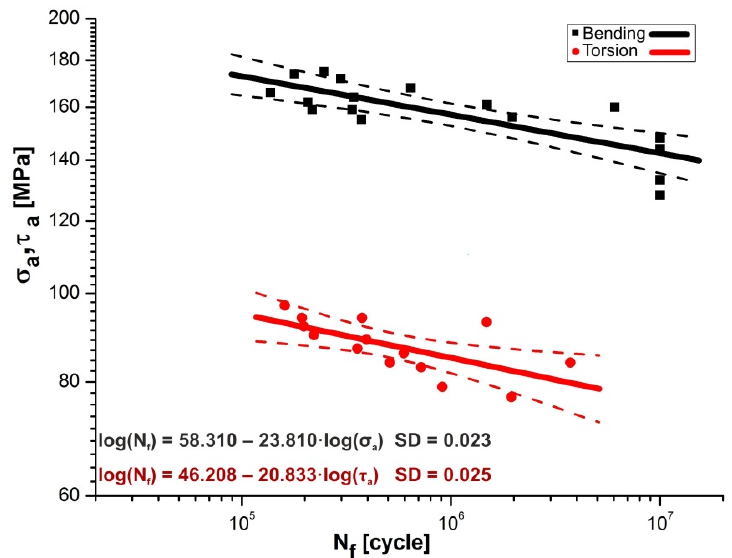
Figure 5. Basquin’s characteristics of regression lines with confidence interval ( α = 0.05) for AlZn6Mg0.8Zr alloy after supersaturation in water from temperature of 500 °C.